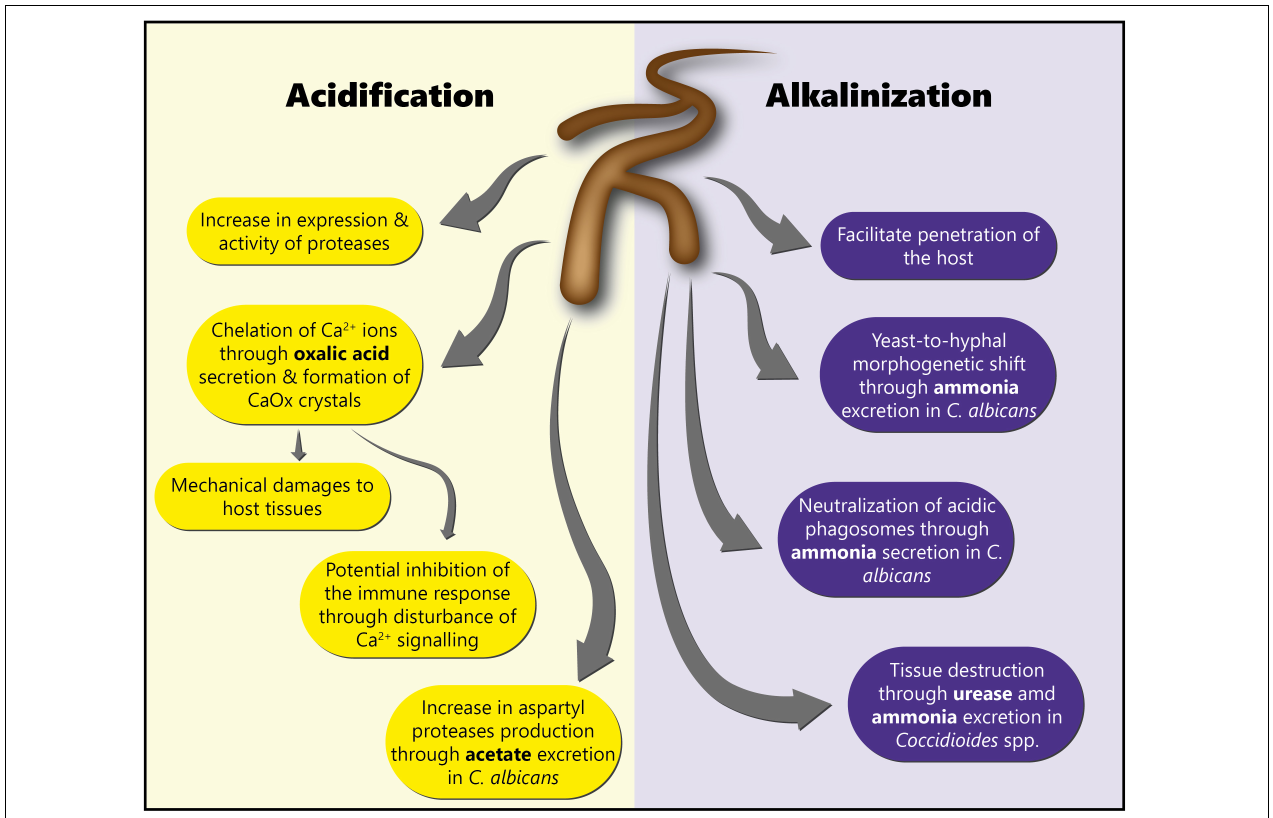
FIGURE 3 | Roles of acidification and alkalinization mechanisms in fungal pathogenesis. This scheme summarizes the different roles of acidification and alkalinization mechanisms in fungal pathogenesis for the colonization of the host